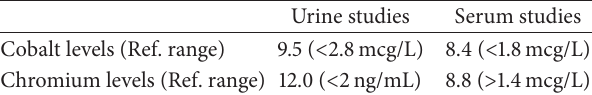
Table 2: Cobalt and chromium levels. Urine studies Serum studies